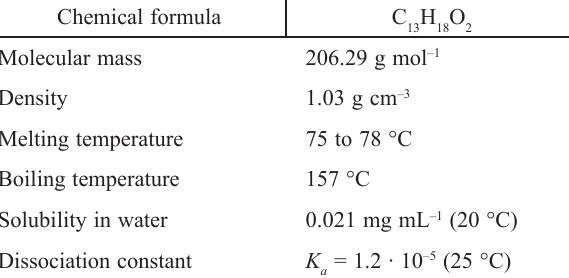
Table 8 – Physicochemical and molecular properties of